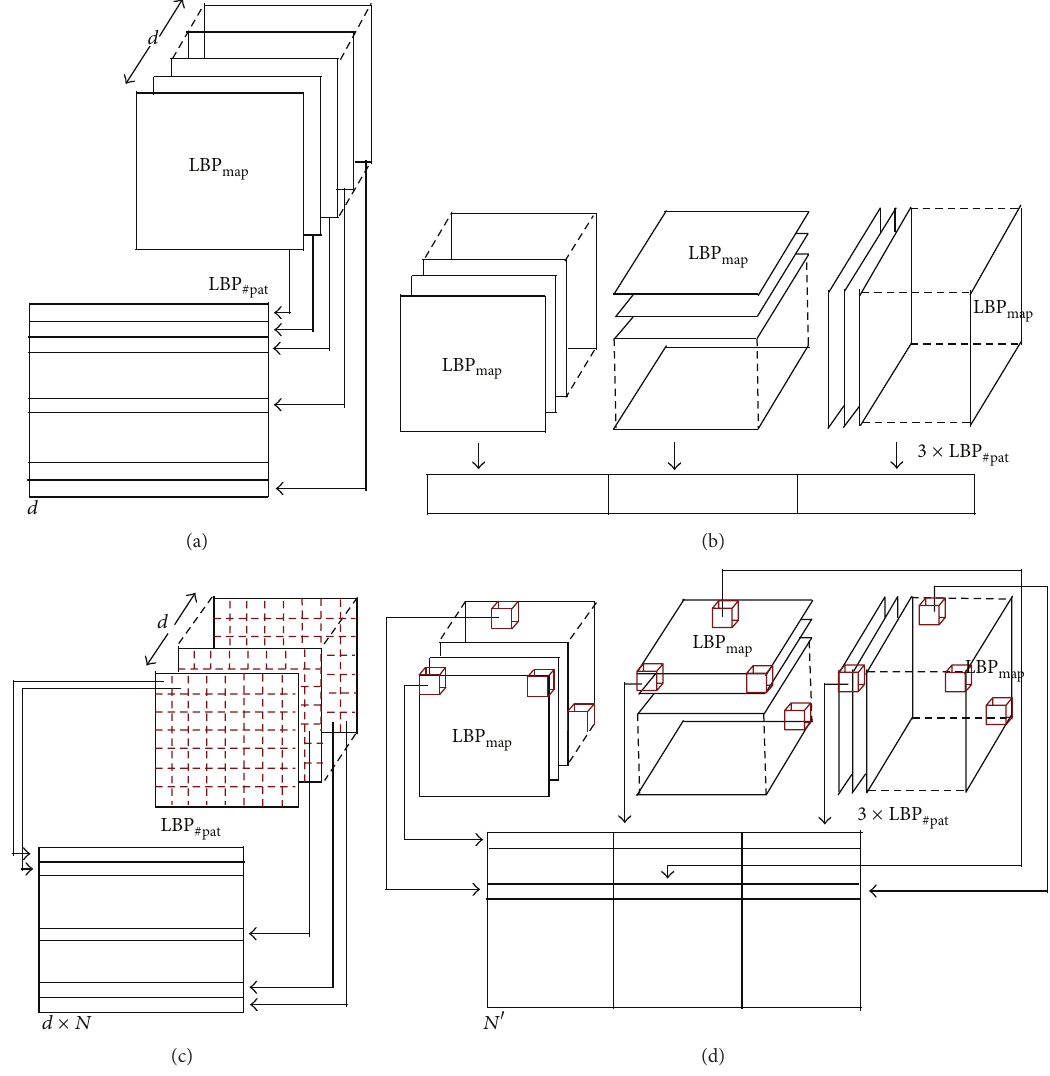
Figure 5: Graphical representation of the feature extraction: (a) extraction of LBP for global mapping, (b) extraction of LBP-TOP for global mapping, (c) extraction of LBP for local mapping, and (d) extraction of LBP-TOP for local